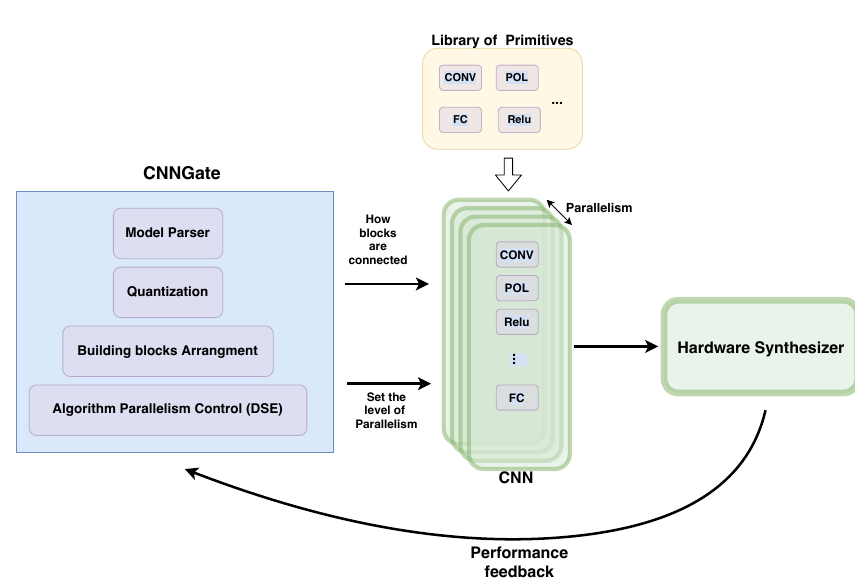
Figure 9. CNN2Gate as an external